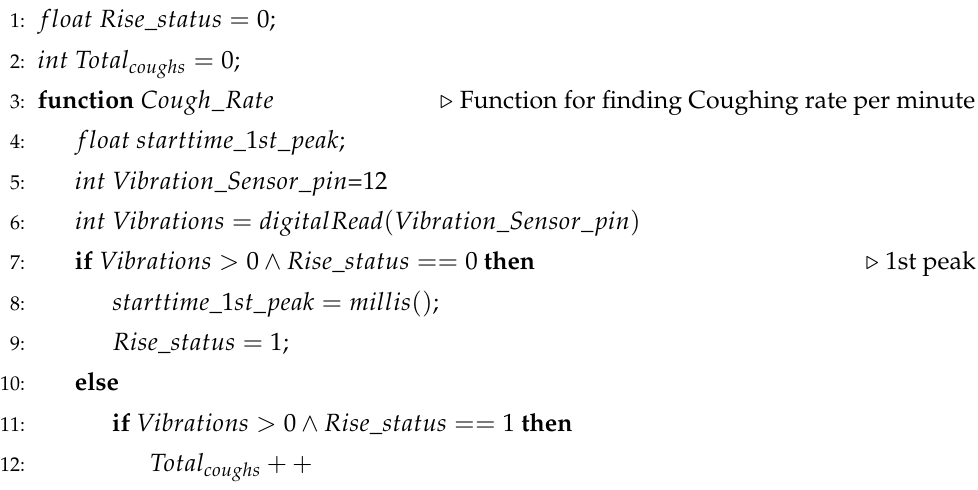
Figure 8. Cough estimation algorithm visualization. Algorithm 3 Measuring Cough rate per